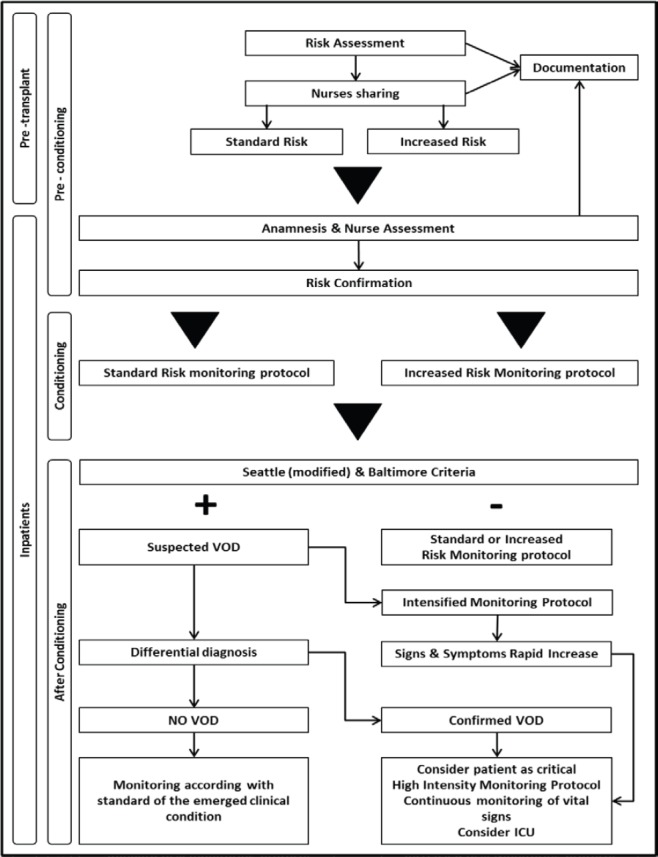
Pathway flow chart.